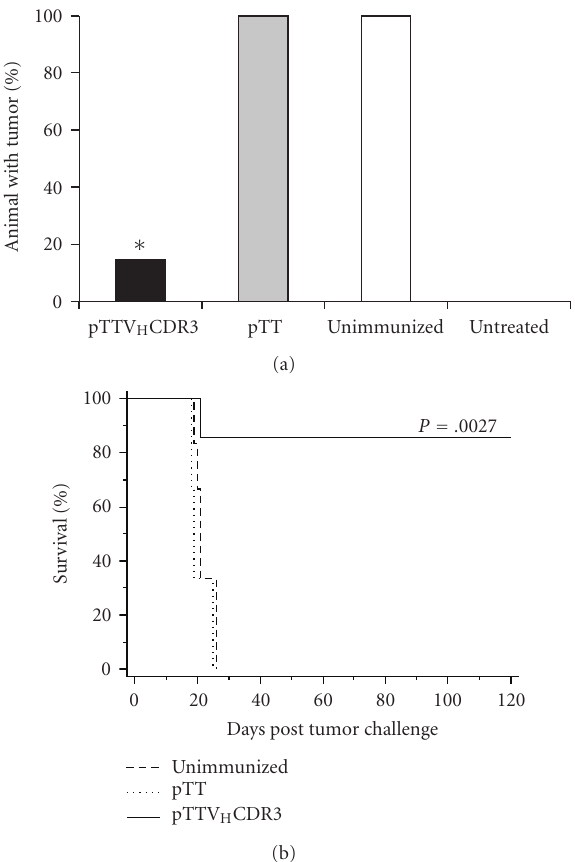
Figure 3: In vivo antitumor e ff ects generated by immunization with pTTV H CDR3 vaccine. (a) Tumor resistance. ( ∗ ) denotes a statistically significant value ( P < . 001) by X 2 analysis when comparing the pTTV H CDR3 group ( n = 7) to all other groups ( n = 6). (b) Representative long-term tumor-free survival. Survival analyses were performed using the Kaplan-Meier method and the log-rank test ( P = .